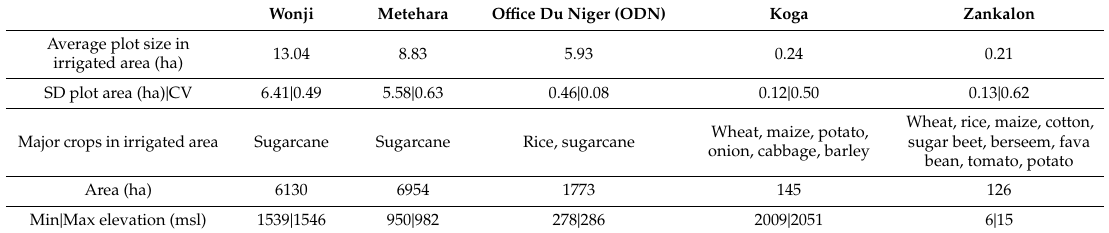
Table 1. Description of irrigated scheme areas used in the product evaluation.